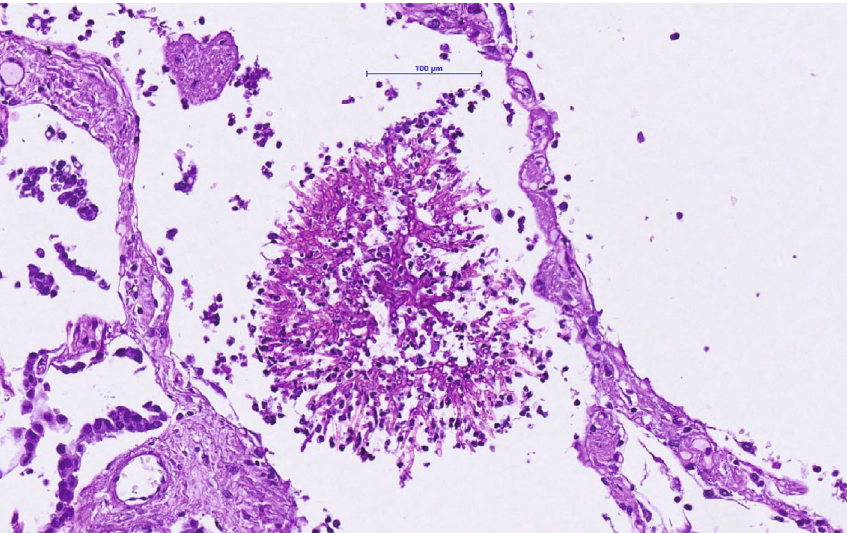
Figure 4: Periodic acid-Schi ff reaction of aspergillus in the right lower lung lobe (20x magni fi